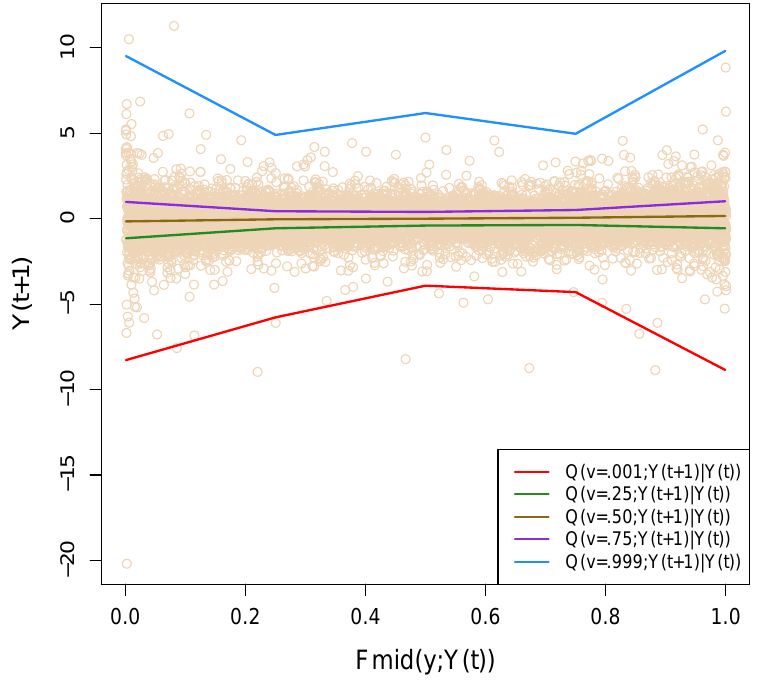
Figure 10. The figure shows estimated non-parametric conditional quantile curves for S&p 500 return data. The red solid line, which represents (cid:98) Q ( 0.001; Y ( t + 1 ) | Y ( t )) , is popularly known as the one-day 0.1% Conditional Value at Risk measure (CoVaR).